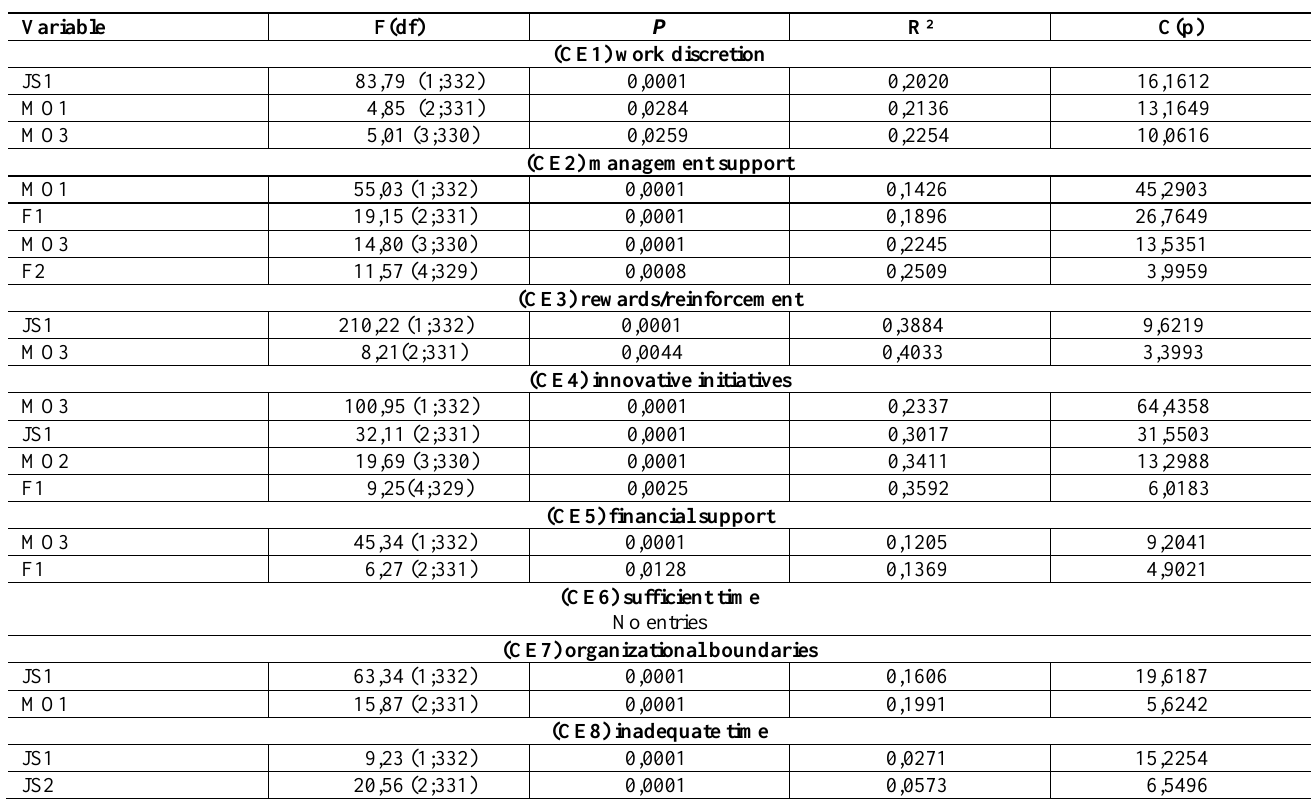
Table 2: Results of multiple regression analysis with CE1, CE2, CE3, CE4, CE5, CE6, CE7 and CE8 as the dependent